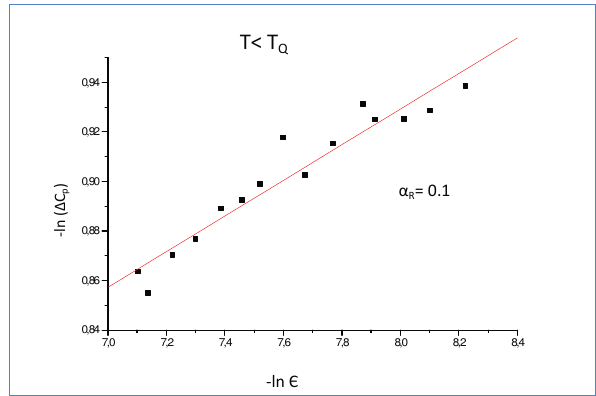
Figure 2. The specific heat (cid:3)C p as a function of the re- duced temperature ( (cid:4) D j T (cid:2) T Q j =T Q ) below the transition temperature ( T Q D 578 ı C) for the ˛ - ˇ phase transition in quartz according to Eq. (2). ˛ R represents the renor- malized critical exponent for the specific heat (cid:3)C p from Eq. (3).